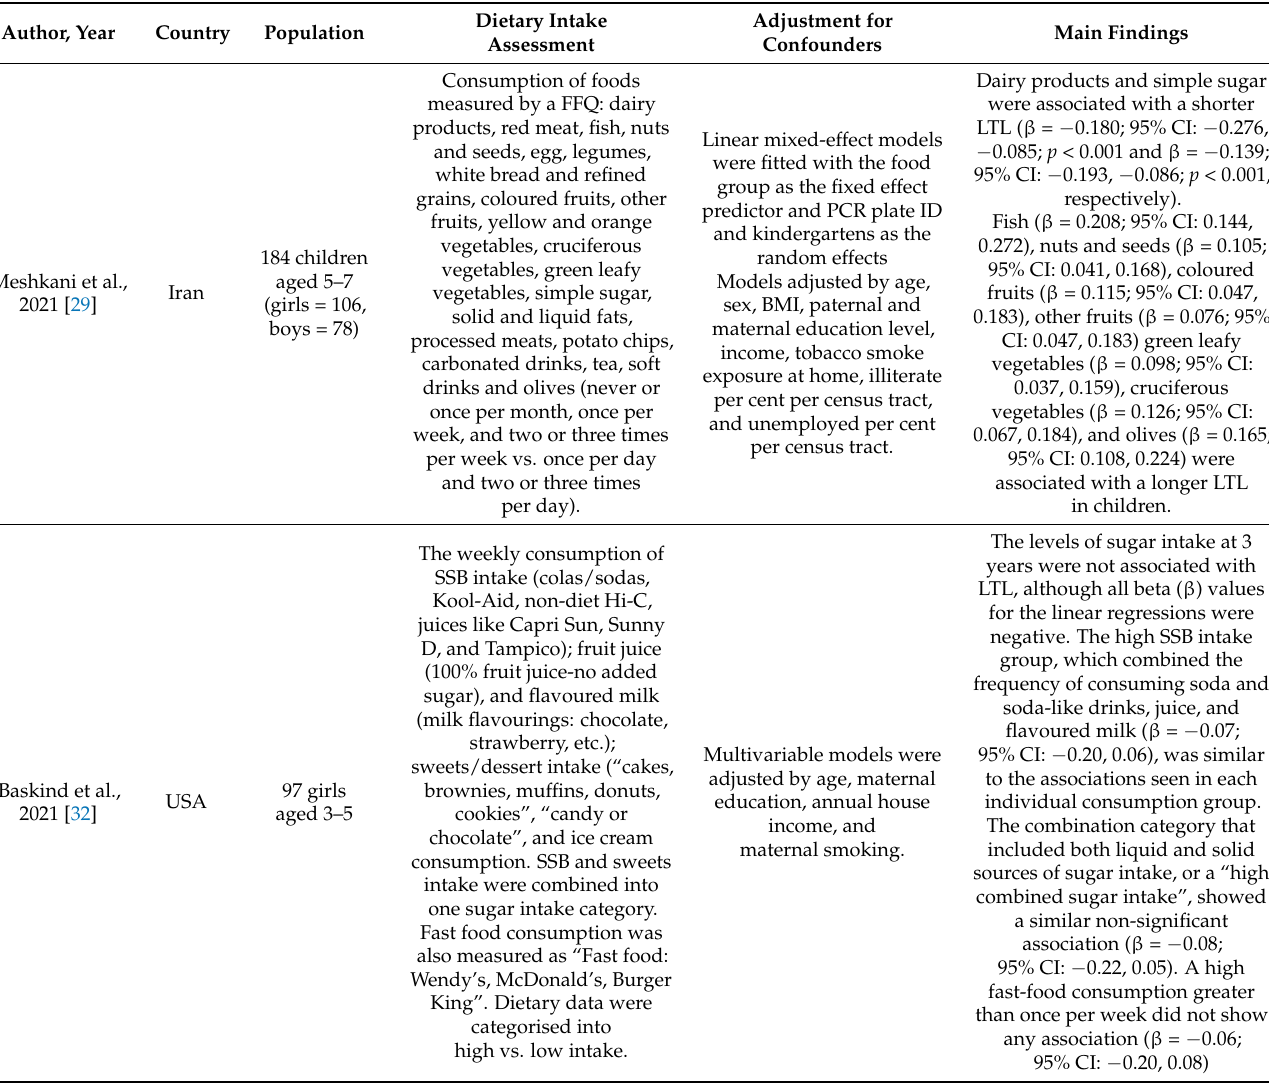
Table 1. Studies focused on dietary determinants of telomere length in children and